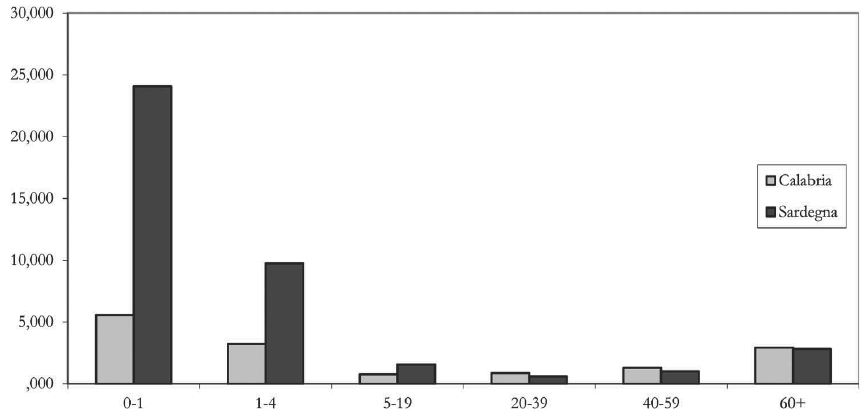
Figure 3a – Malaria age specific mortality rates (both sexes) in Calabria and Sardegna,